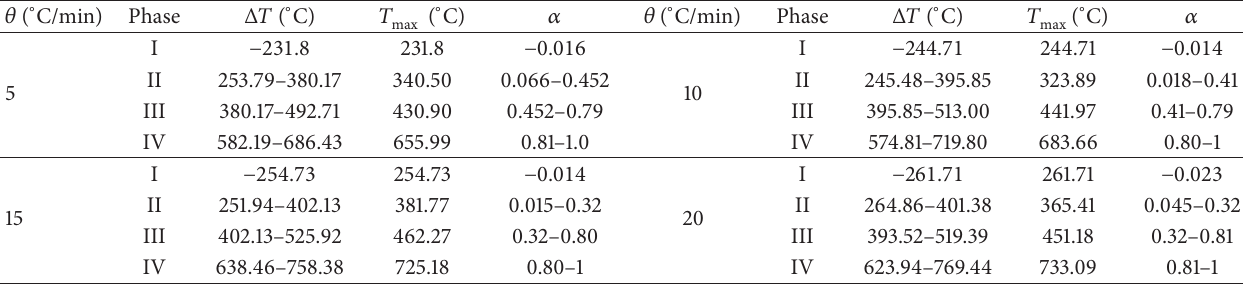
Table 1: The summary of pyrolysis characteristic temperatures at the heating rate from 5 to 20 ∘ C min −1 .